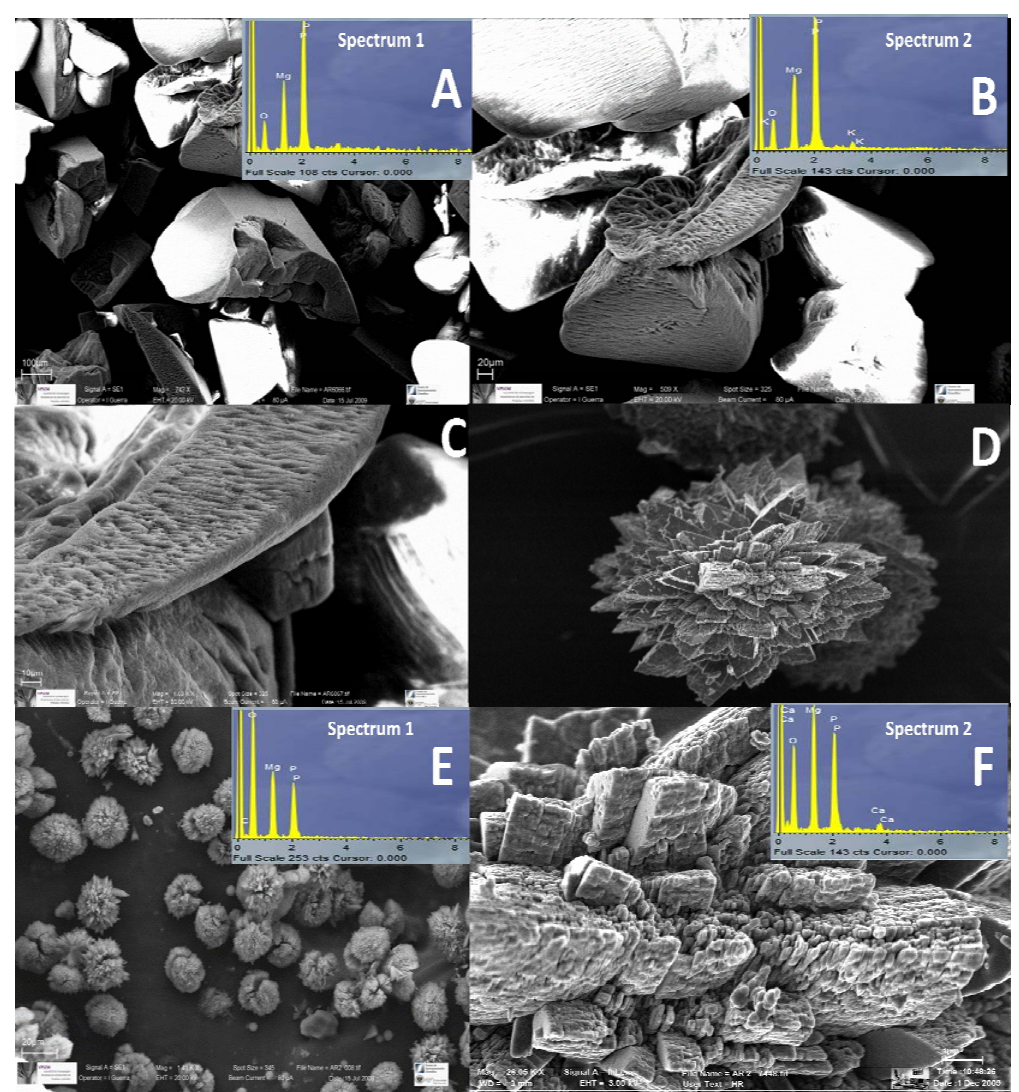
Figure 5. Photomicrographs of scanning electron microscope (SEM) and field emission scanning electron microscope of struvite crystals ( A – C ) and bobierrite and Mg spherulites ( D – F ) formed in solid media where certain morphological details can be seen. Energy dispersive X-ray microanalysis (EDX) spectra of struvite crystals and spherulites are included in the